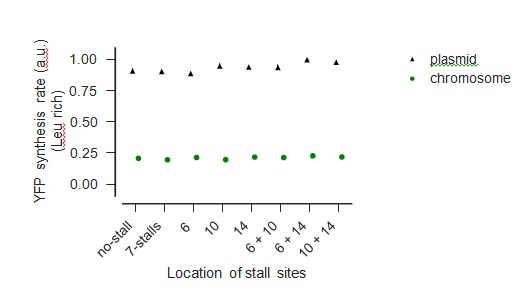
Comparison of measured YFP levels when expressed from chromo- some and plasmid during Leu-rich growthDOI: